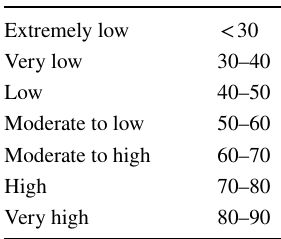
Table 11 Vulnerability